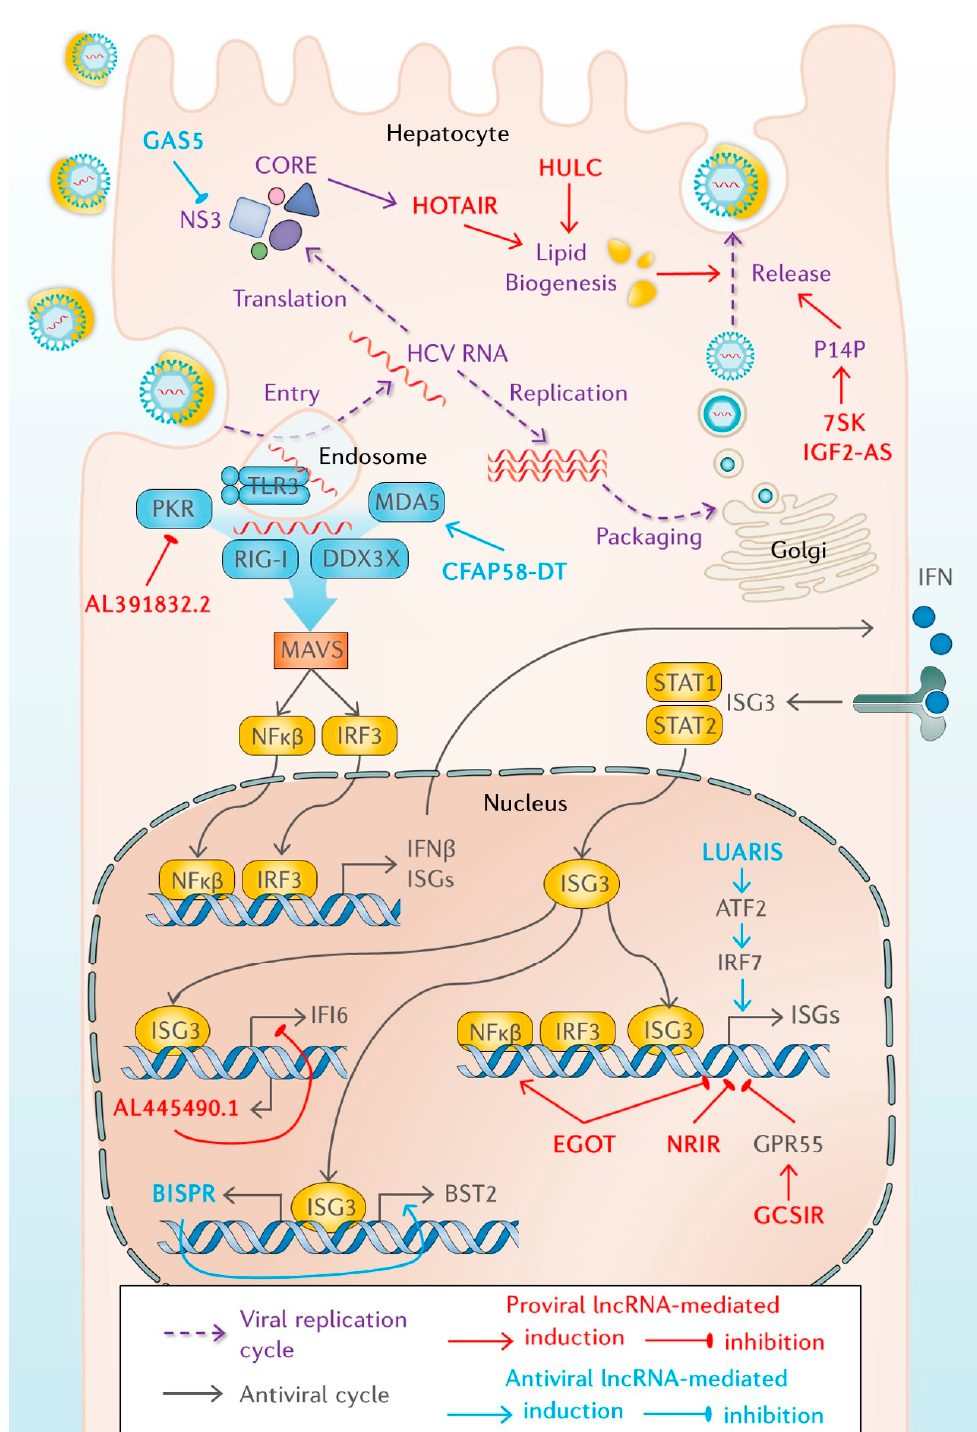
Figure 1. Long non-coding RNAs (lncRNAs) deregulated during the replication cycle or the antiviral response of hepatitis C virus (HCV)-infected cells. See text for details.